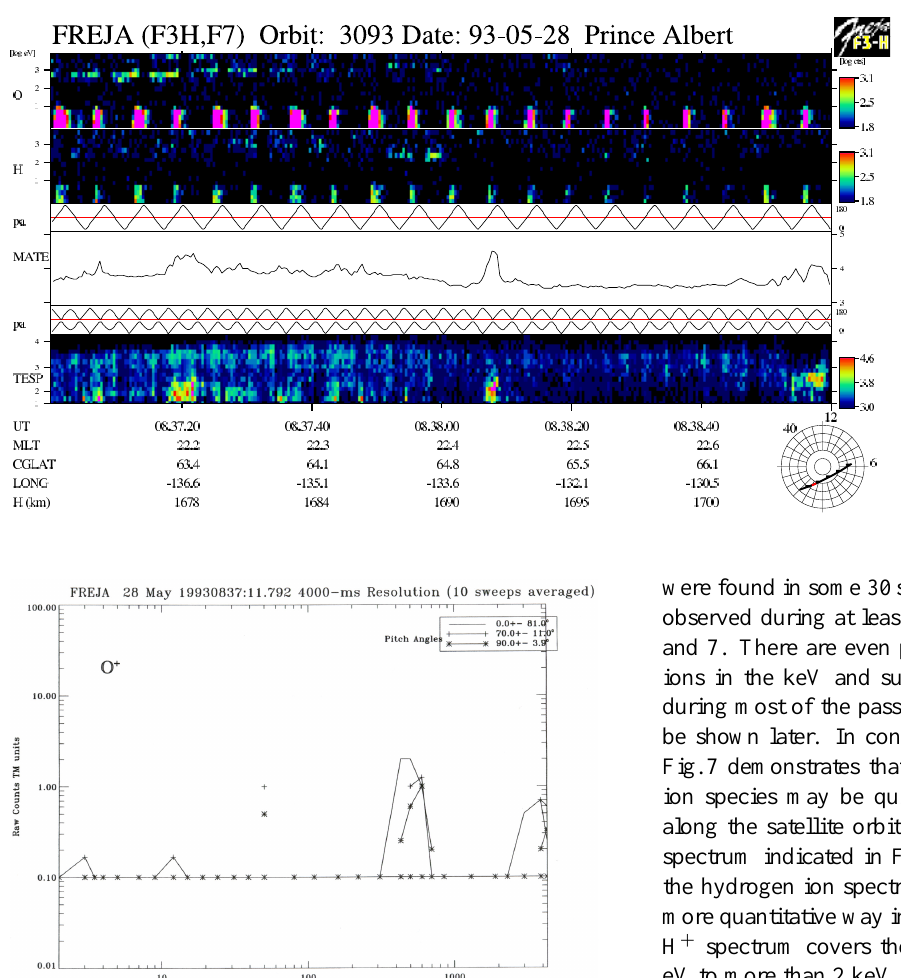
Fig. 10. A measured detailed energy distribution of the count rate for O + ions obtained in the period represented in Fig. 9. The straight line is the 1-count